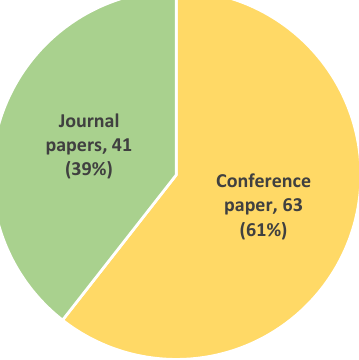
Figure 4. Number of papers from different types of publication.